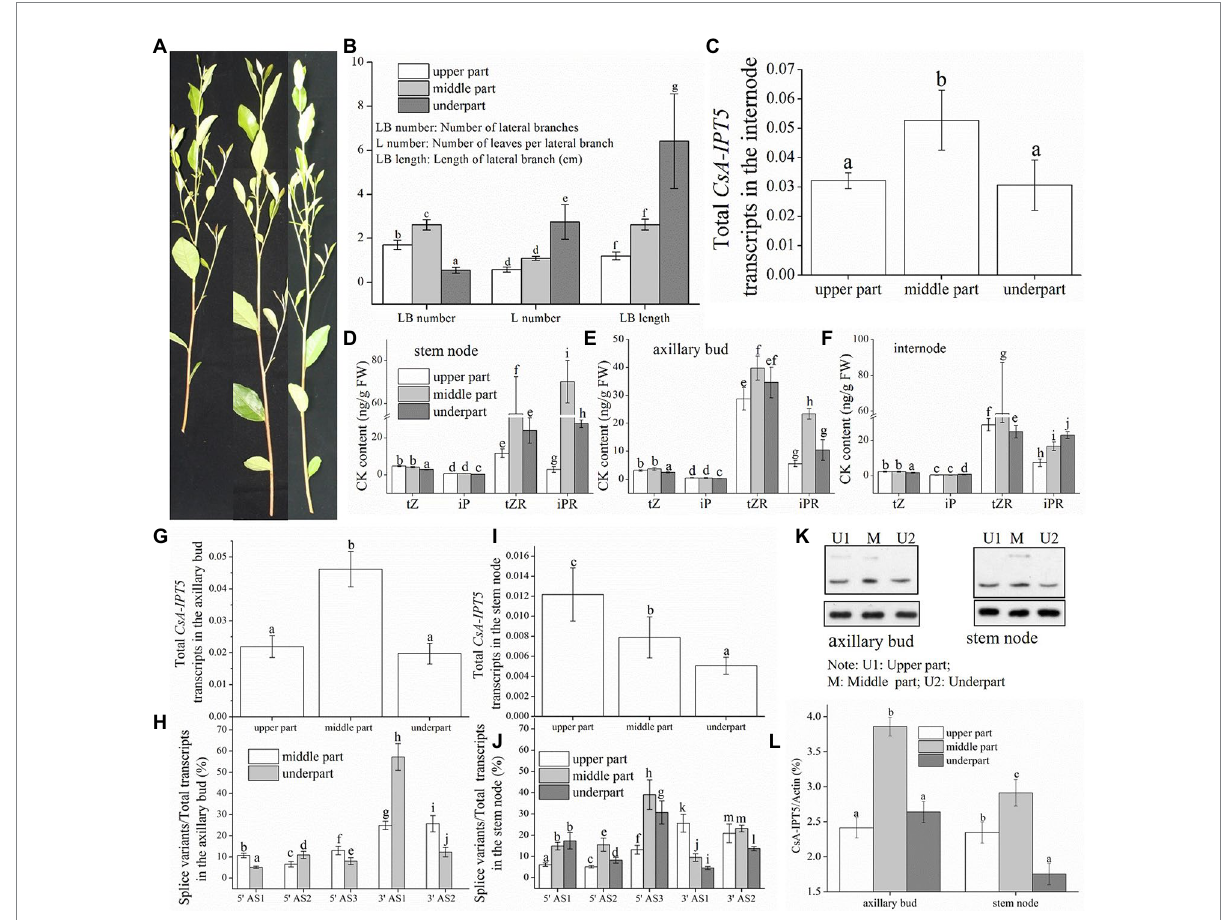
FIGURE 4 The branch phenotype, CK contents and the expression levels of CsA-IPT5 transcripts and CsA-IPT5 protein in the different tissues of three positions of the tea plant new shoot. The branch phenotype (A,B) and CK contents in the three tissues (D–F) of three positions of tea plant new shoot. (C,G–J) Expression levels of CsA-IPT5 transcripts in the three tissues of three positions of the new shoot. Western blot (K) and ‘CsA-IPT5/ Actin’ (L) display the expression levels of CsA-IPT5 protein in the axillary bud and stem node in the three positions of the new shoot. Data are means ± SD ( n = 3 or 6). For each figure, letters show marked differences in each index or each tissue among three positions of the new shoot ( p < 0.05, Duncan’s multiple range